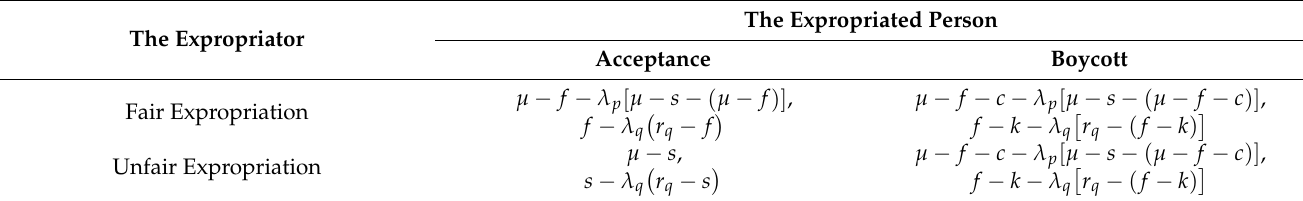
Table 2. The loss aversion game matrix of urban housing expropriation